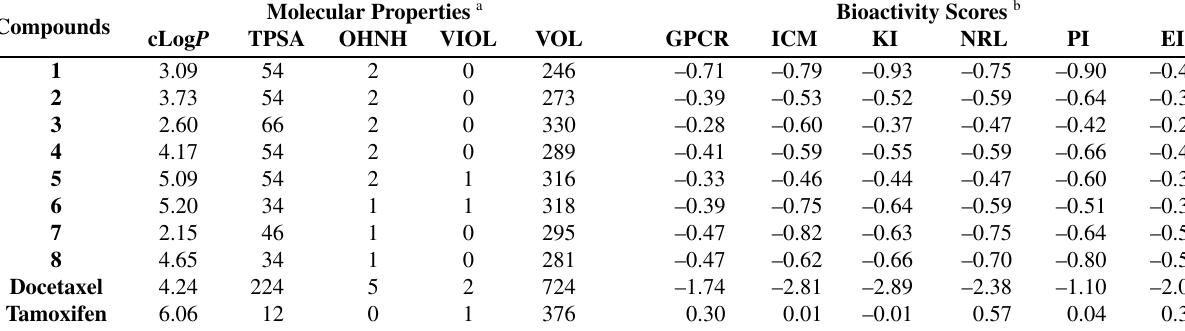
Table 5. Molinspiration calculations of compounds (1–8)